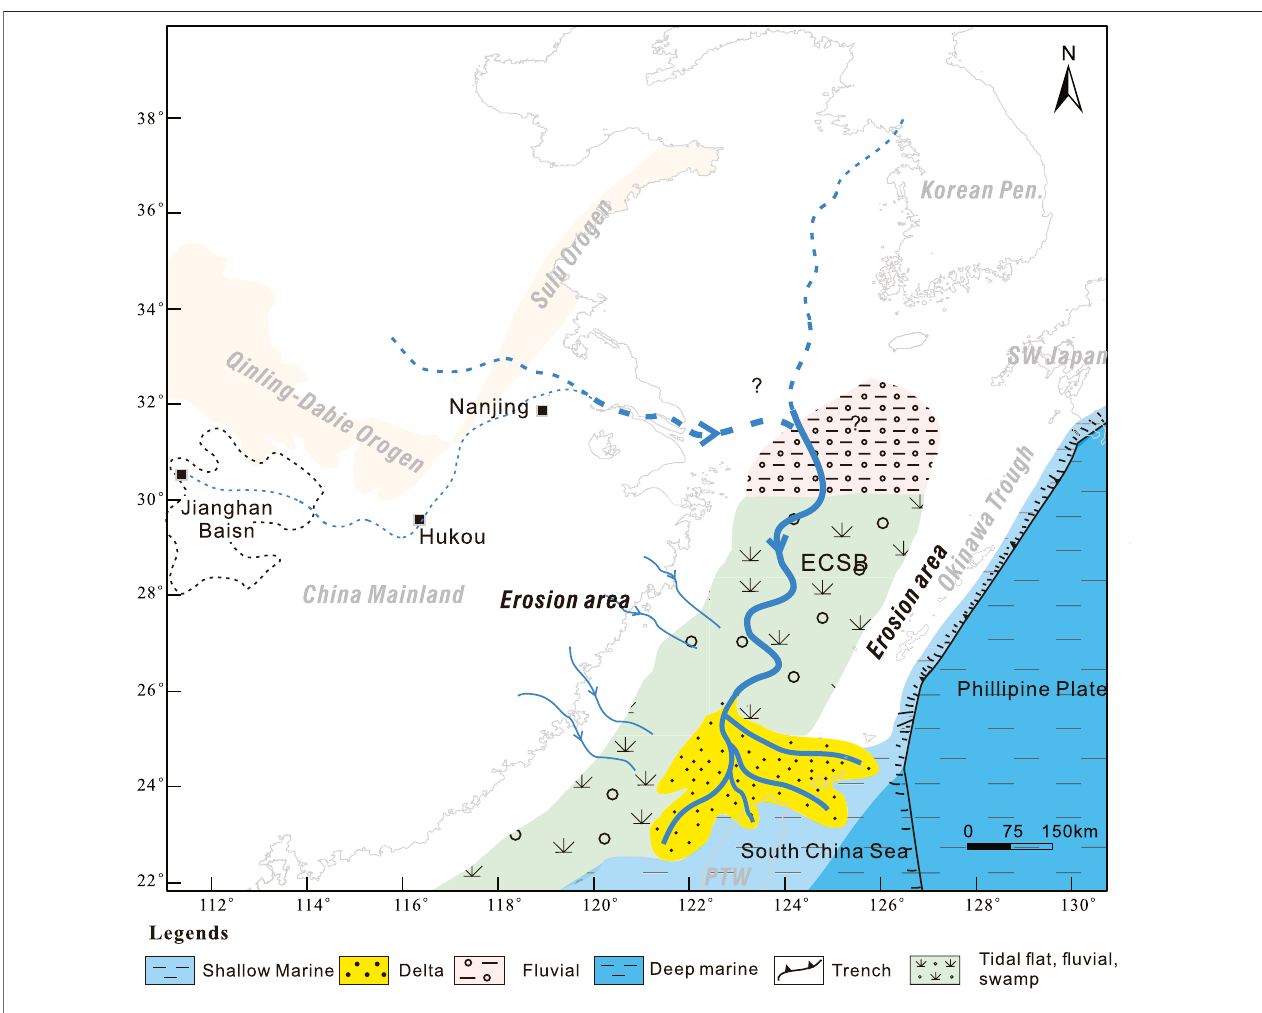
FIGURE 6 | Schematic map showing the sediments delivered from the source areas to the paleo-Taiwan region. PTW, paleo-Taiwan.